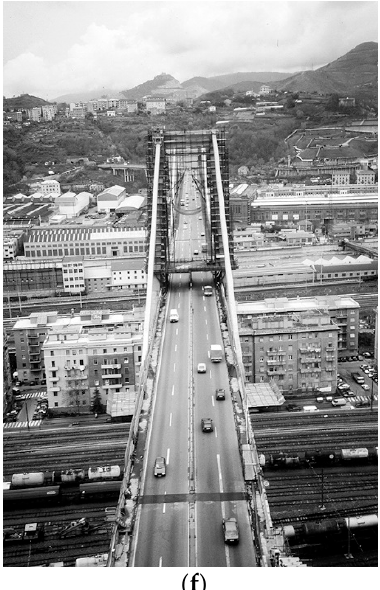
Figure 8. ( a ) Support No. 11 with strengthened north-eastern concreted cable (photo by Rymsza; 04.1993). ( b ) Strengthening of the concreted cable with long external tendons—view from the deck (photo by Rymsza; 04.1993). ( c ) The north-western concreted cable after strengthening—view from the top of pylon No. 11 (photo by Rymsza; 04.1993). ( d ) Steel cap on pylon No. 11 (photo by Rymsza; 04.1993). ( e ) The south-western concreted cable before strengthening—view from the top of pylon No. 11 (photo by Rymsza; 04.1993). ( f ) View from the top of pylon No. 11 to pylon No. 10 with scaffolding (photo by Rymsza; 04.1993).